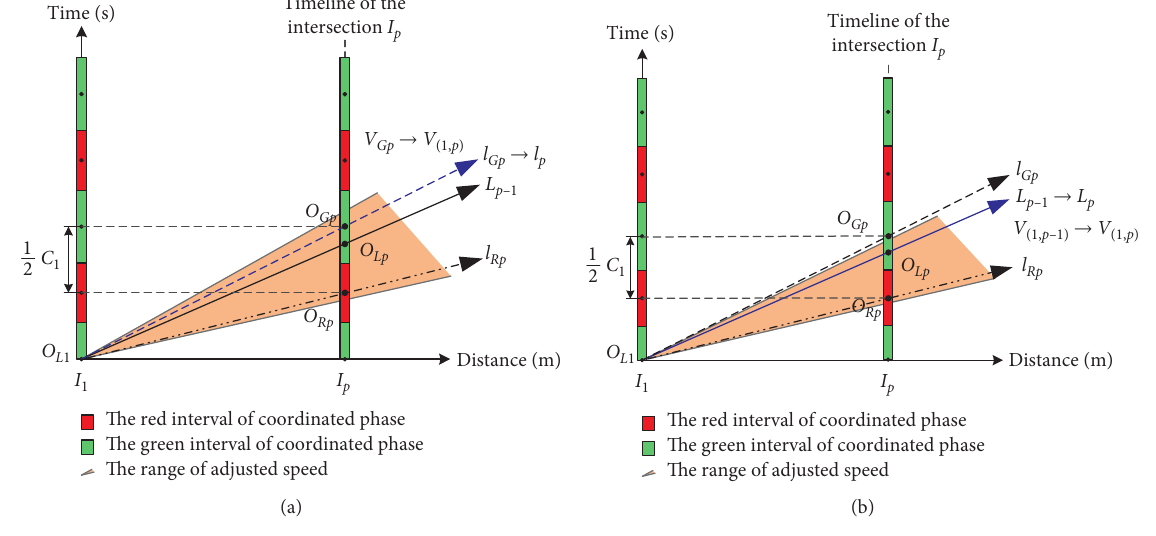
Figure 5: The PTC line updating under synchronous coordinated